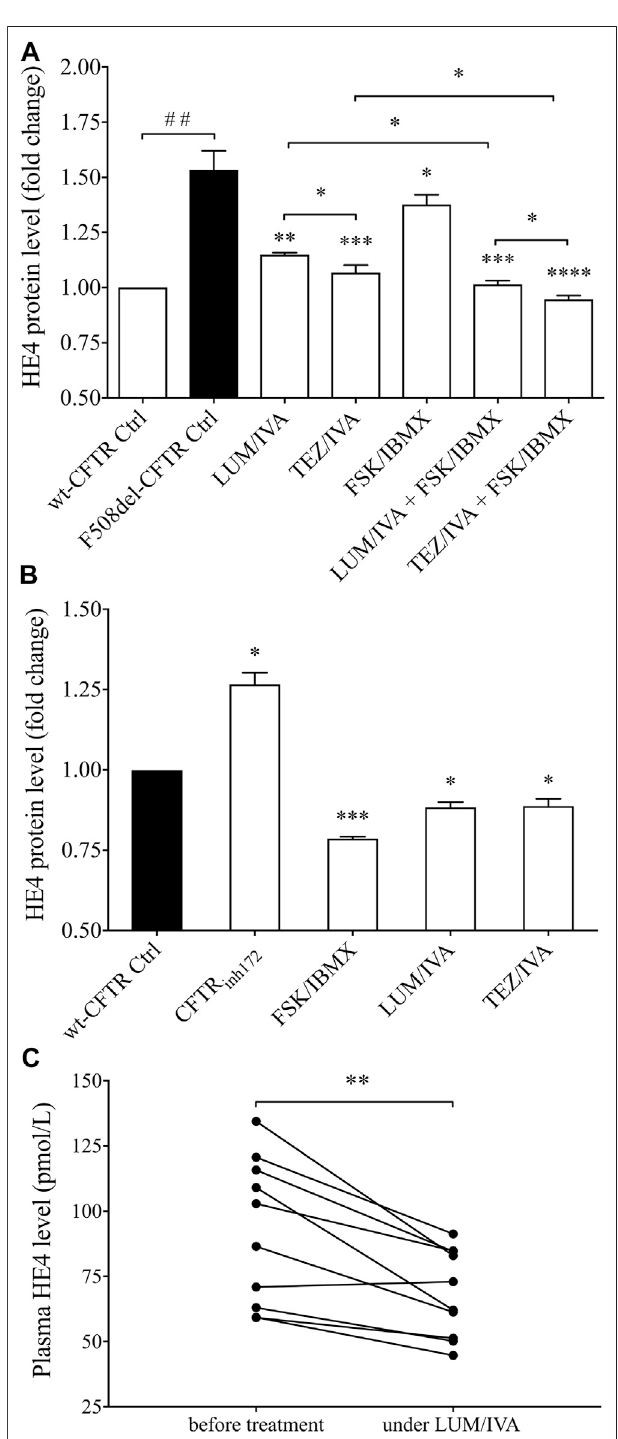
FIGURE 2 | Analysis of HE4 levels in the supernatant of F508del-CFTR or wt-CFTR CFBE 41o − cells with pharmacologically altered CFTR function and inplasmasamplesofCFsubjectsunderLUM/IVA therapy.BothLUM/IVA (3/10 μ M) andTEZ/IVA(5/10 μ M)resultedindecreasedHE4 inF508del- CFTR CFBE 41o − cells after 24 h approaching the level of normal cells. CFTR activator FSK/IBMX (10/100 μ M) alone moderately reduced HE4, while combined treatment of FSK/IBMX with CFTR modulators showed an even ( Continued )